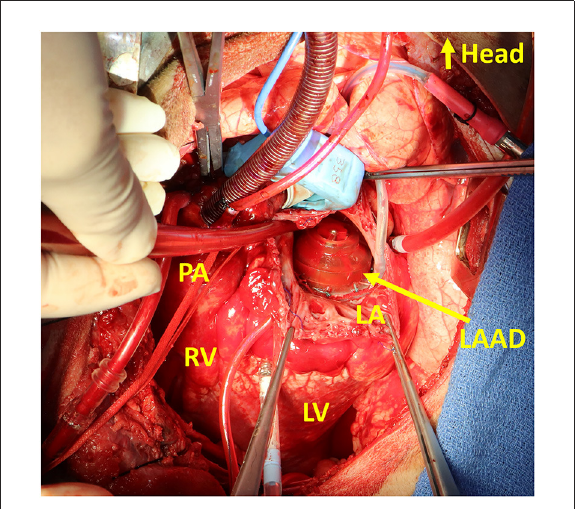
FIGURE2 Intraoperative photo of the Left Atrial Assist Device (LAAD) implanted at the mitral position. LA, left atrium; LV, left ventricle; PA, pulmonary artery; RV, right